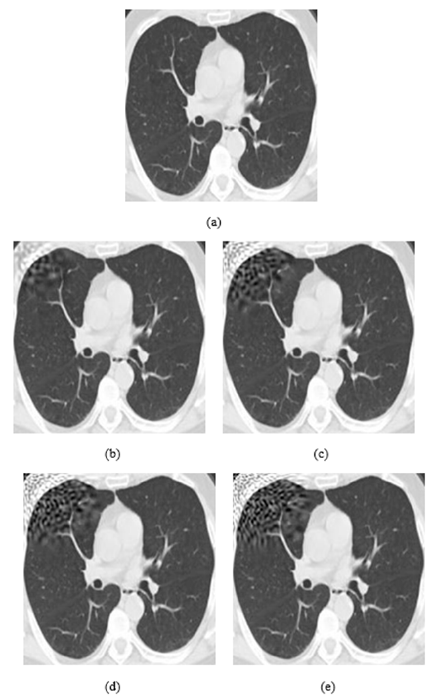
Figure 5. ( a ) Initial image, ( b ) L ‐ bit = 200, ( c ) L ‐ bit = 500, ( d ) L ‐ bit = 800, ( e ) L ‐ bit = 800. The rest parameters are Embedding strength = 300, p 1 = 0.1, p 2 = 0.1.